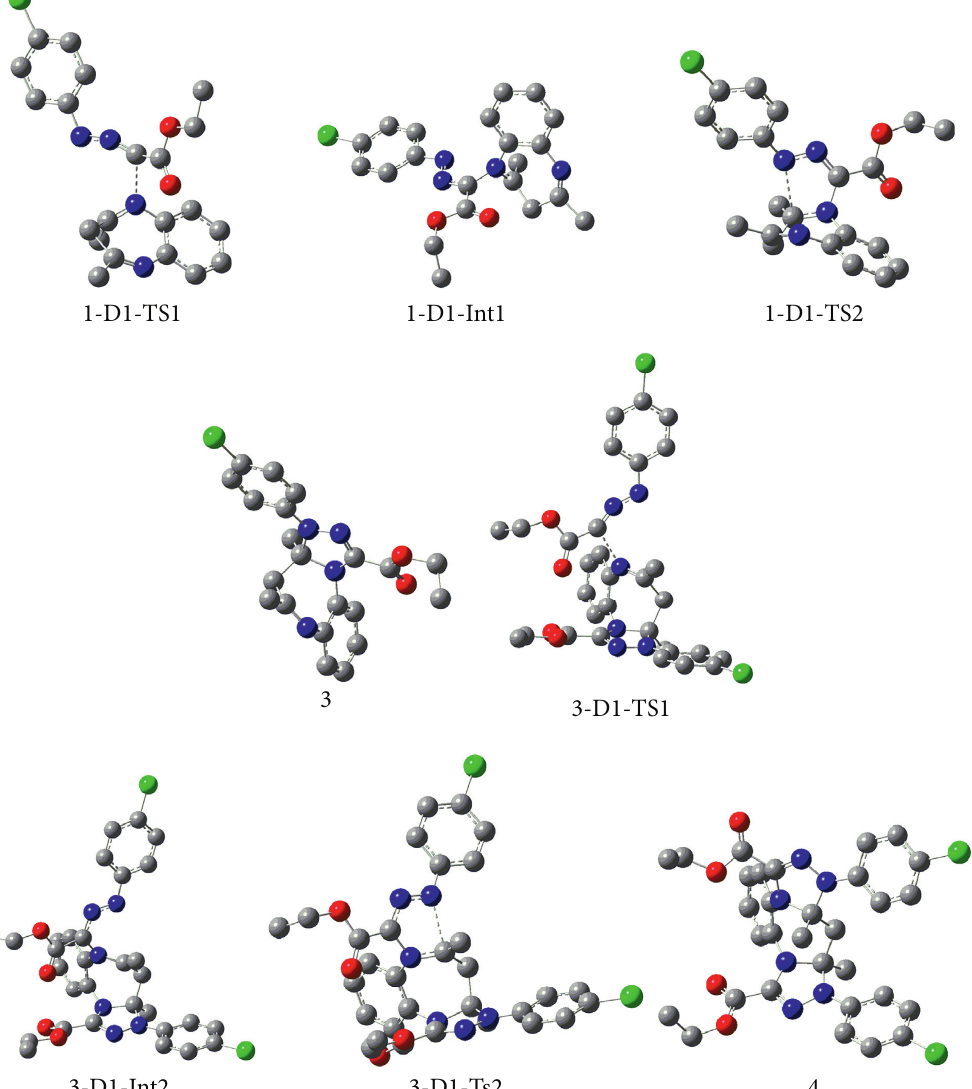
Figure 4: Selected optimized geometries of intermediates and TSs computed at B3LYP/6-31G(d) level of theory for DAC of 2,4-dimethyl- 3H-1,5-benzodiazepine 1 with N-aryl-C-ethoxycarbonylnitrilimine 2 (hydrogen atoms have been omitted for clarity). Table 3: Relative energies a ( Δ E ) of the low-lying isomers for 1,3-DC of benzodiazepine 1 and dipole D1 at B3LYP/6-31G(d) level. Approach 1 Approach